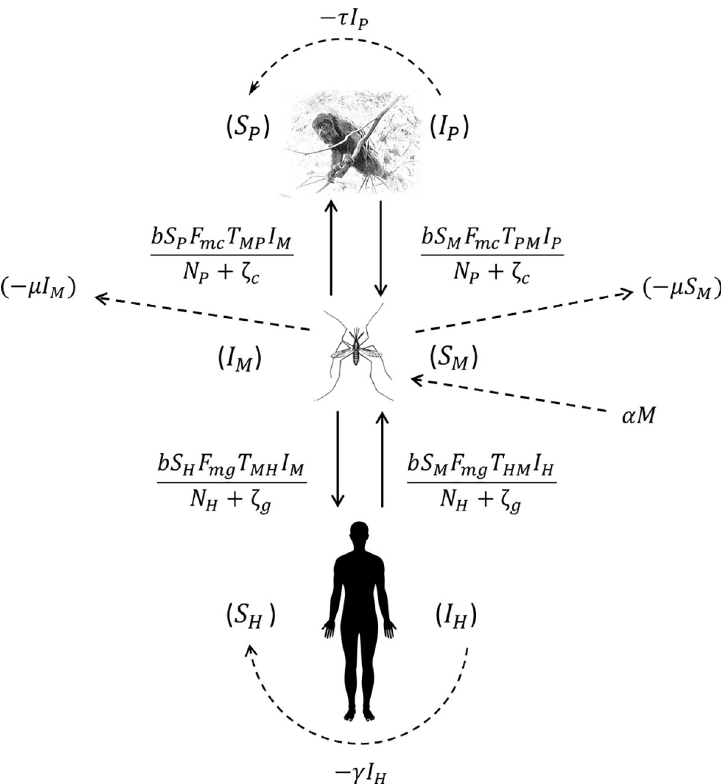
Fig 1. Schematic model of the dynamics of Plasmodium transmission among humans, mosquitoes and monkeys. The solid arrows and the formulae beside them indicate vector-host and host-vector transmission and the rate at which this transmission occurs. The curved dashed arrows and the formulae beside them indicate host recovery, i.e., transfer from the infected to the susceptible compartment, and the rate at which this occurs. The straight dashed arrows indicate the population dynamics of the